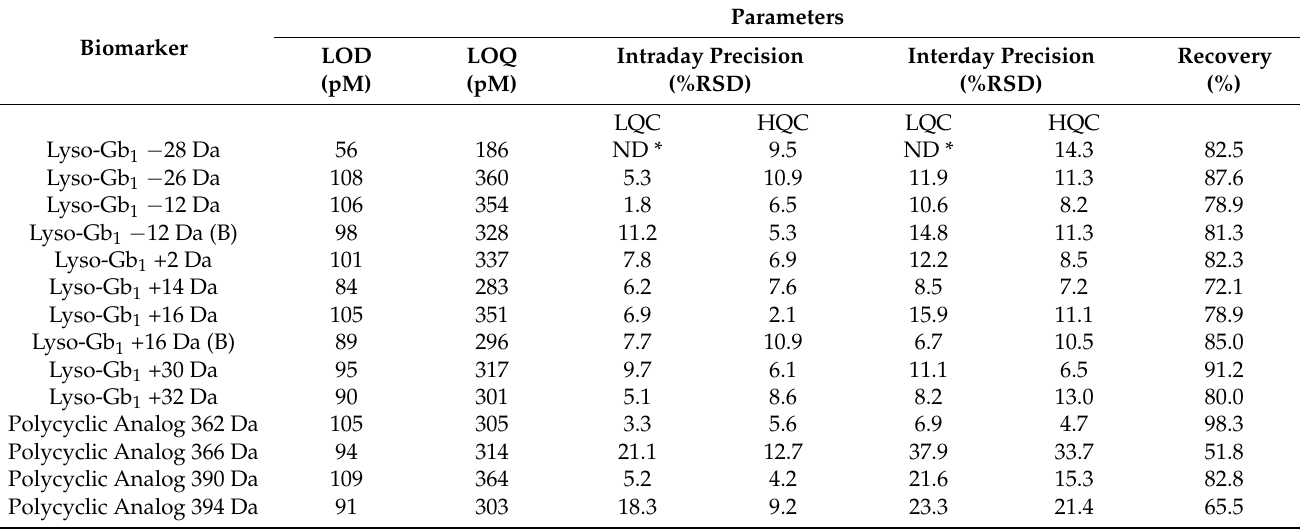
Table 3. Method validation results for lyso-Gb 1 analogs and polycyclic